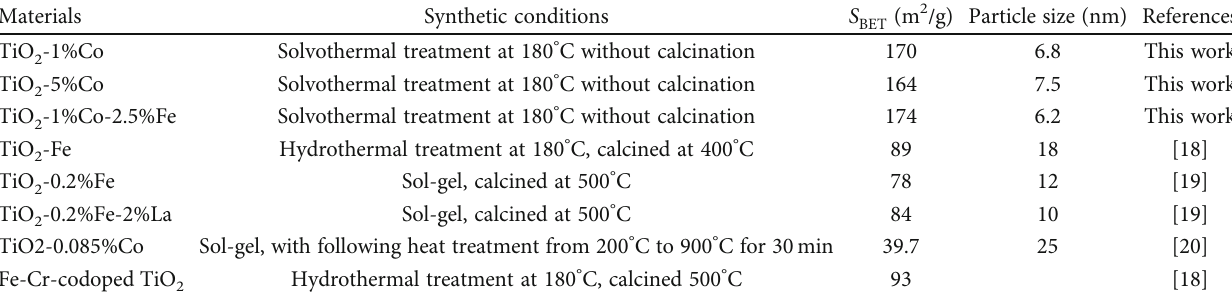
samples prepared in this work with those of previous works. 2